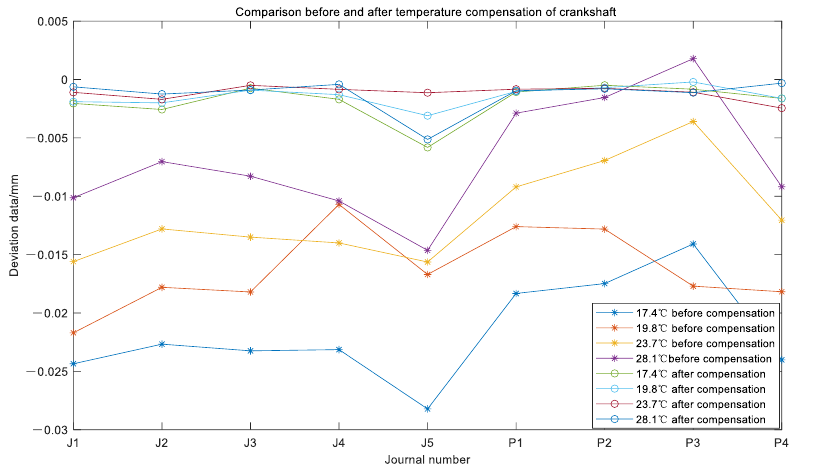
Figure 14. The deviation value measured before and after temperature compensation (* is deviation before compensation, o is deviation after